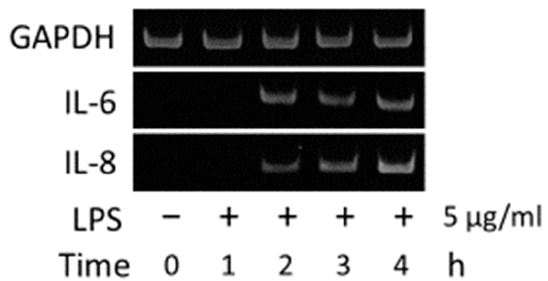
Figure 5. LPS enhances IL-6 and IL-8 gene expression in hGFs.